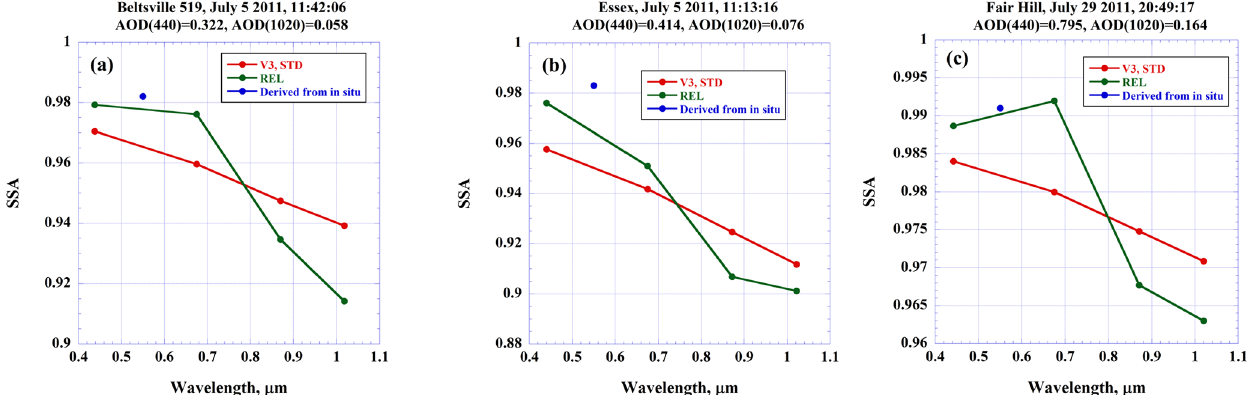
Figure 11. Comparison of SSA retrieved by V3 aerosol inversion code employing the STD assumption on IPRI smoothness constraints and SSA retrieved by inversion code using the REL assumption on SSA derived from in situ measurements: (a) Beltsville AERONET site, 440nm AOD = 0.322, (b) Essex AERONET site, 440nm AOD = 0.414 and (c) Fair Hill AERONET site, 440nm AOD =